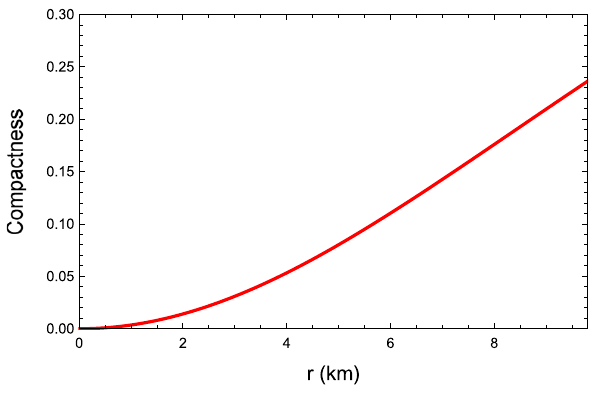
Fig. 12 Variationofcompactnesswithradialcoordinate r isincreasing in nature